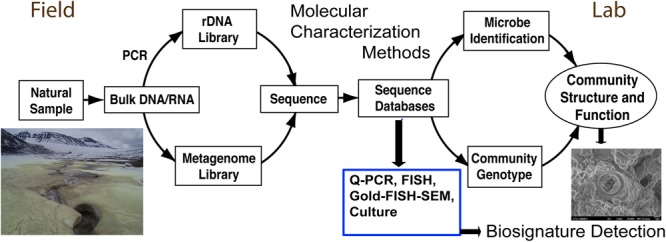
Microbial analysis is typically characterized in the field context with sample collection (left), for further analyses and culturing in the laboratory leading to the eventual biosignature detection (right). Currently, modern environmental samples are more conducive to biosignature detection than ancient samples that lack good preservation of DNA.